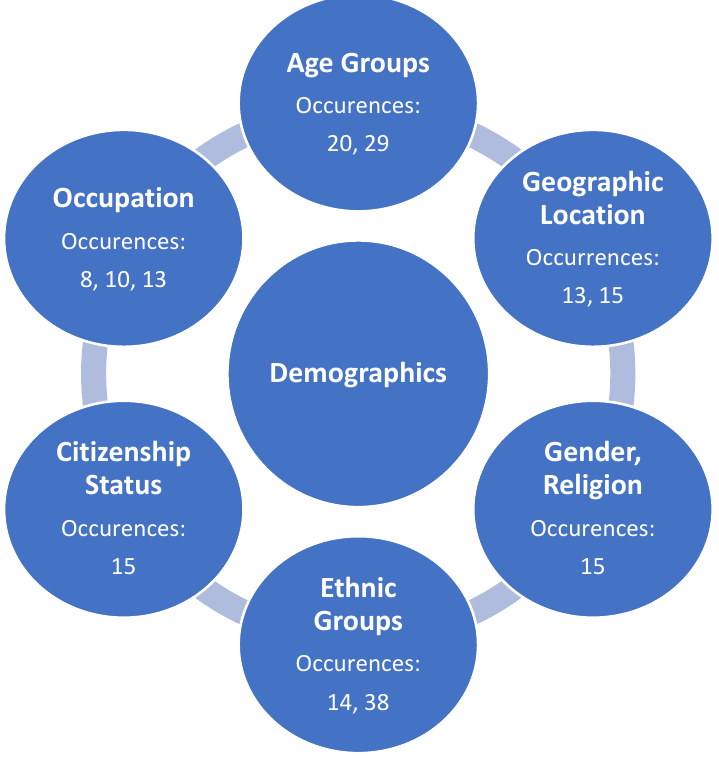
Figure 4. Identified sub-themes (underlying sub-constructs) identified protective demographic factors of mental health distress during the COVID-19 pandemic in the United States.